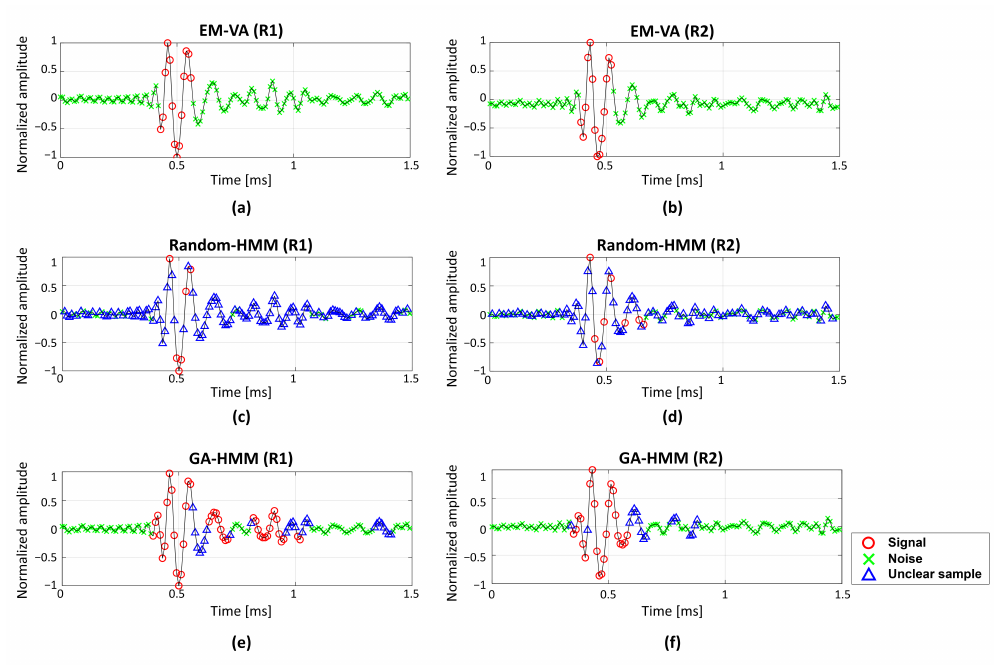
Figure 8. Detection results for signals measured by two receivers (R1 and R2). ( a ) Single-measurement detection result of EM-VA for R1; ( b ) single-measurement detection result of EM-VA for R2; ( c ) average detection result of multiple-measurement Random-HMM for R1; ( d ) average detection result of multiple-measurement Random-HMM for R2; ( e ) average detection result of multiple-measurement GA-HMM for R1; ( f ) average detection result of multiple-measurement GA-HMM for R2. Averaged values of the states from multiple-measurement Random-HMM and multiple-measurement GA- HMM are between 0 and 1. Samples exhibiting values exceeding 0.7 and less than 0.3 were classified as “signal” and “noise,” respectively. The remaining samples exhibiting values between 0.3 and 0.7 were “unclear samples”. Symbols of “o”, “x”, and “ (cid:52) ” represent “signal”, “noise”, and “unclear samples,”